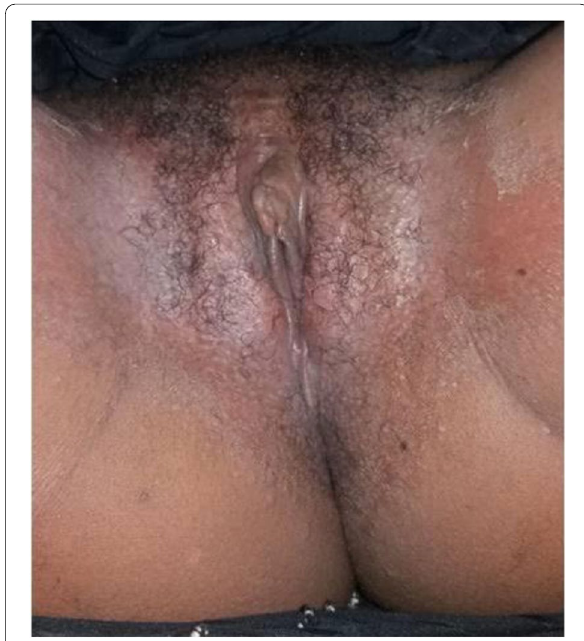
Fig. 4 Clinical picture at 6th post-operative